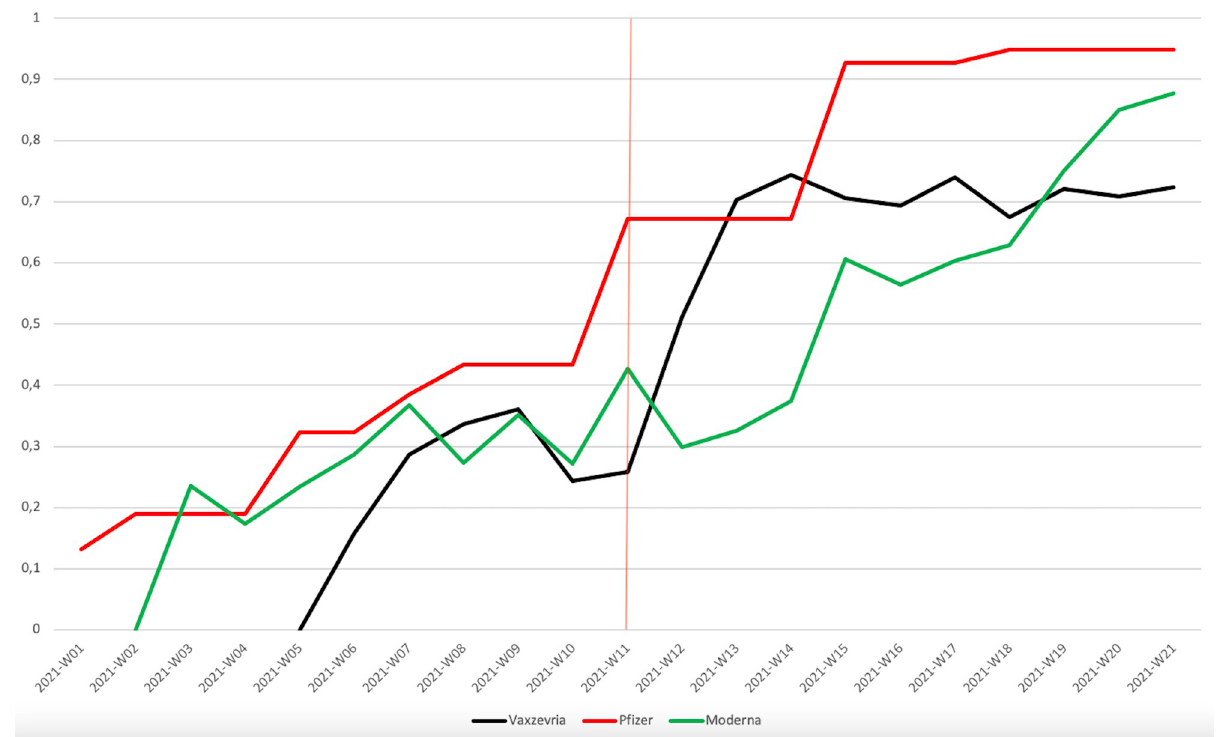
Fig 7. Proportion of administered doses in Luxembourg, by manufacturer. Notes : Source: https://vaccinetracker.ecdc.europa.eu.